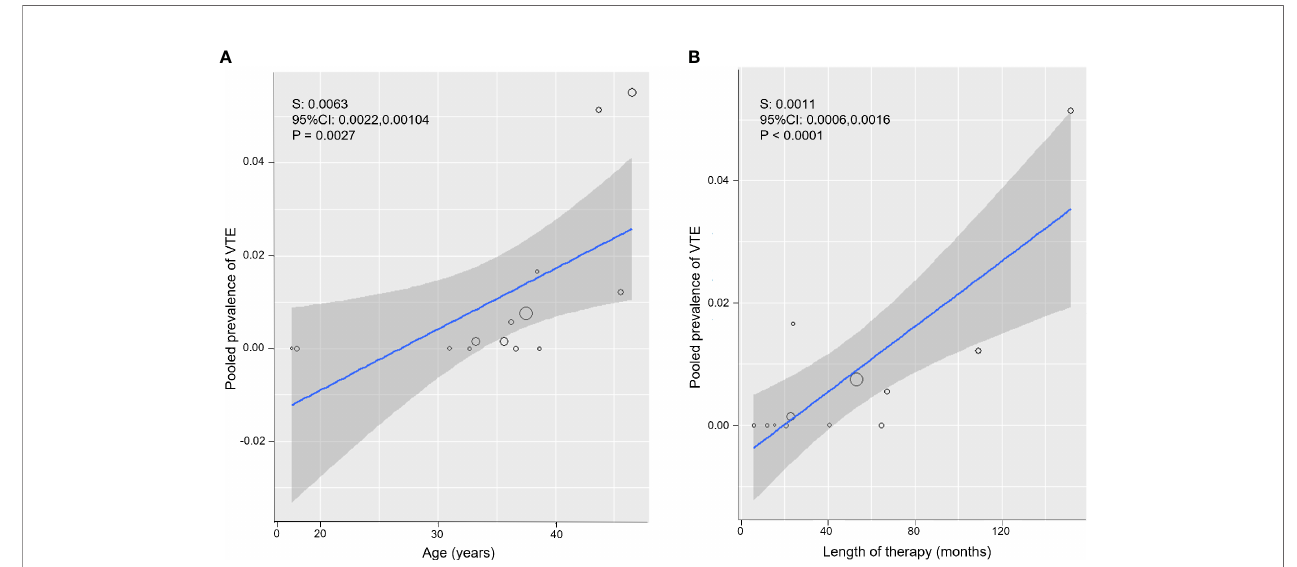
FIGURE 3 | Meta-regression bubble plots: prevalence of venous thromboembolism (VTE) in Assigned Males at Birth (AMAB) trans people as a function of the mean age (A) and mean length of estrogen therapy (B) . The predicted effects (solid line) with corresponding con fi dence intervals (gray range) are also shown. CI, con fi dence interval; S,